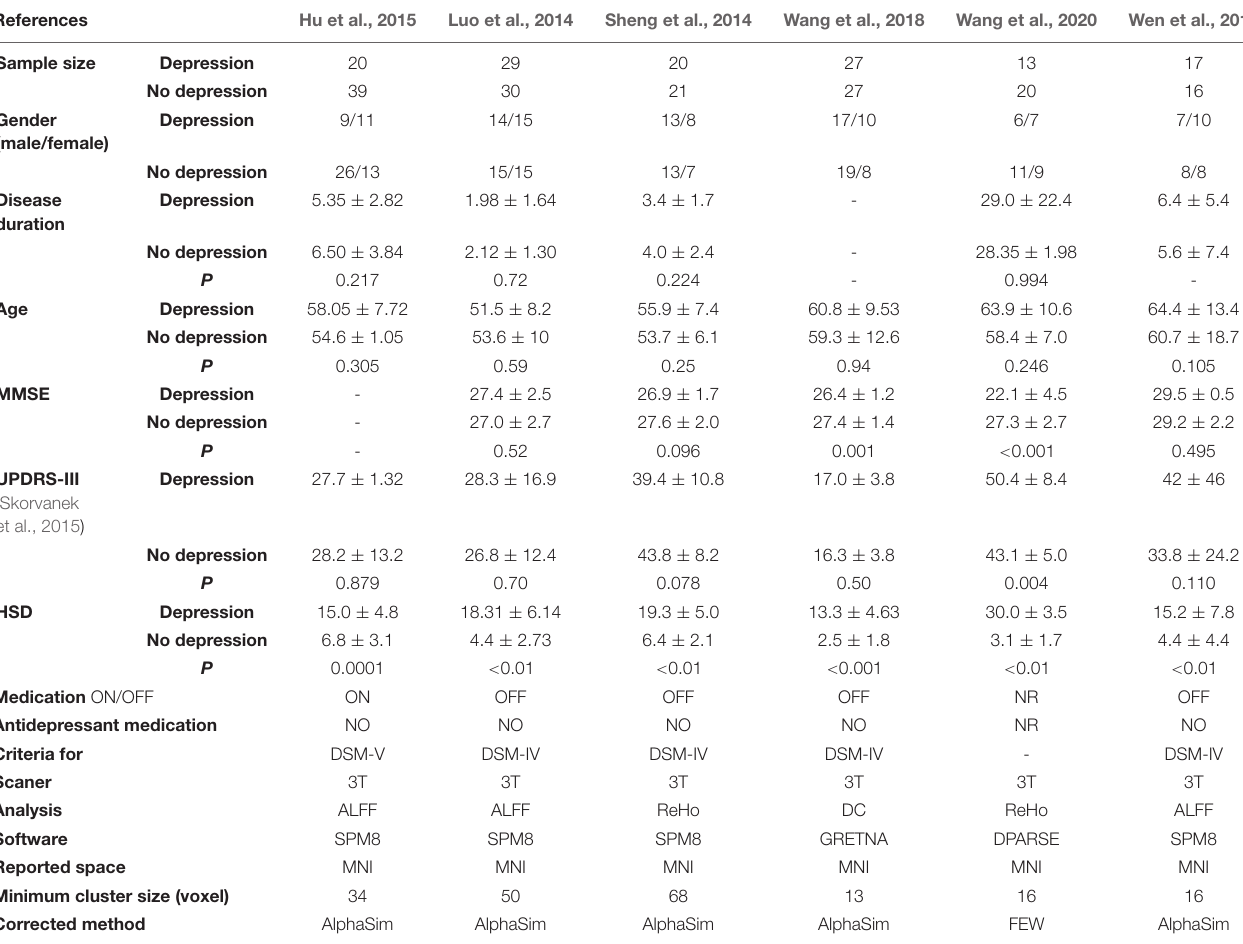
TABLE 2 | Demographic characteristics and experimental design of the included studies.